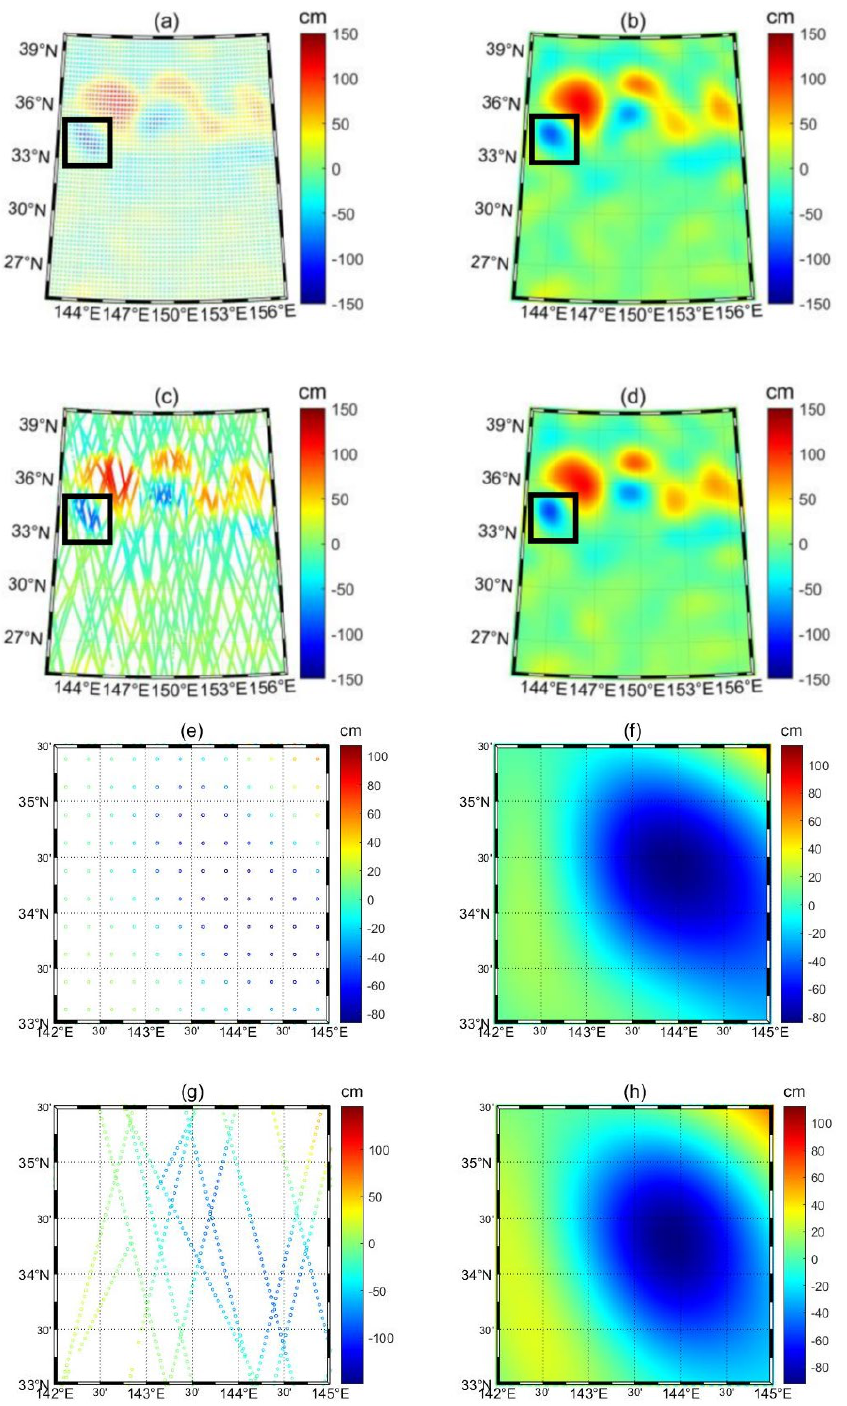
Figure 19. ( a ) Initial gridded reanalysis data. ( b ) The corresponding result of B-spline surface fitting based on gridded reanalysis data. ( c ) Initial along-track data. ( d ) The corresponding result of B-spline surface fitting based on along-track data. ( e – h ) are the data source and fitting result of a single cyclone eddy corresponding to the black box in ( a – d ): ( e ) Gridded data. ( f ) The fitting result based on gridded reanalysis data. ( g ) Along-track data. ( h ) The fitting result based on along-track data.